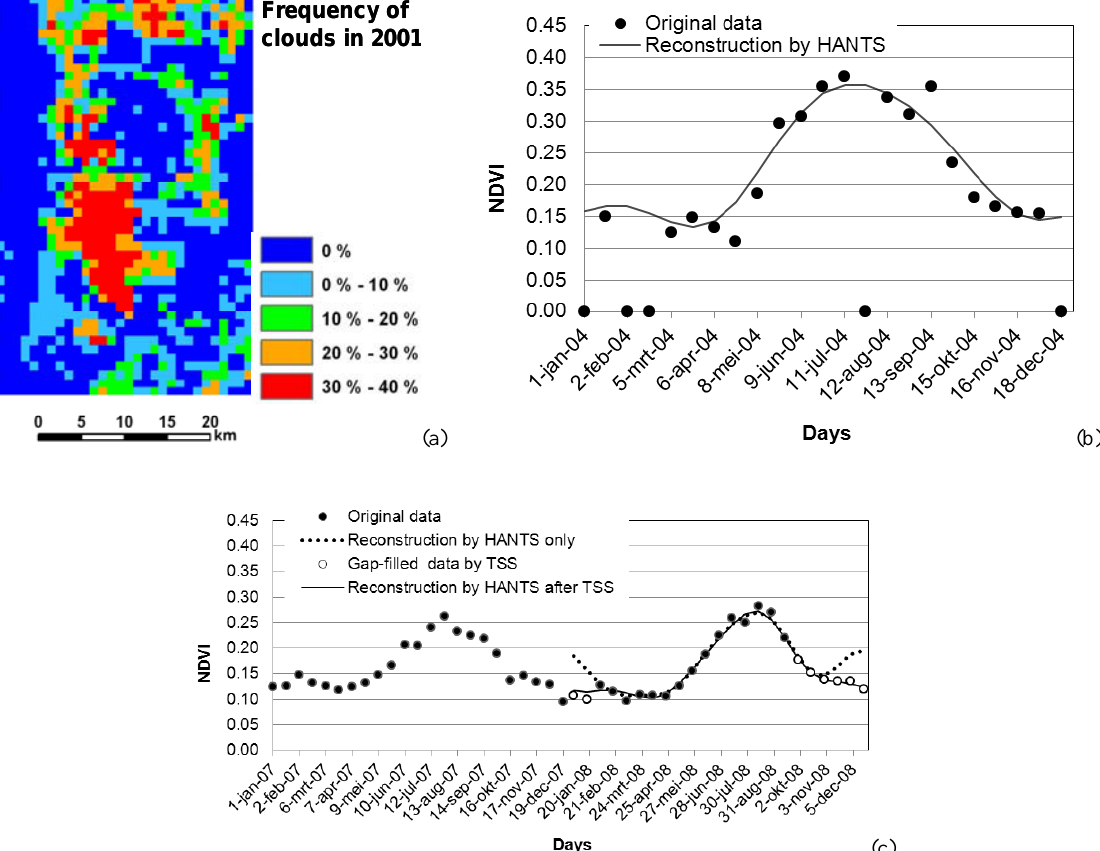
Fig. 3. Evaluation of TSS and HANTS algorithms: (a) percentage of cloudy days in 2001; (b) reconstructed curve is based on the original data with large gaps in the beginning of the year; (c) reconstructed curve is based on the filled dataset by TSS algorithm, large gaps in the beginning of the were initially filled by TSS algorithm.